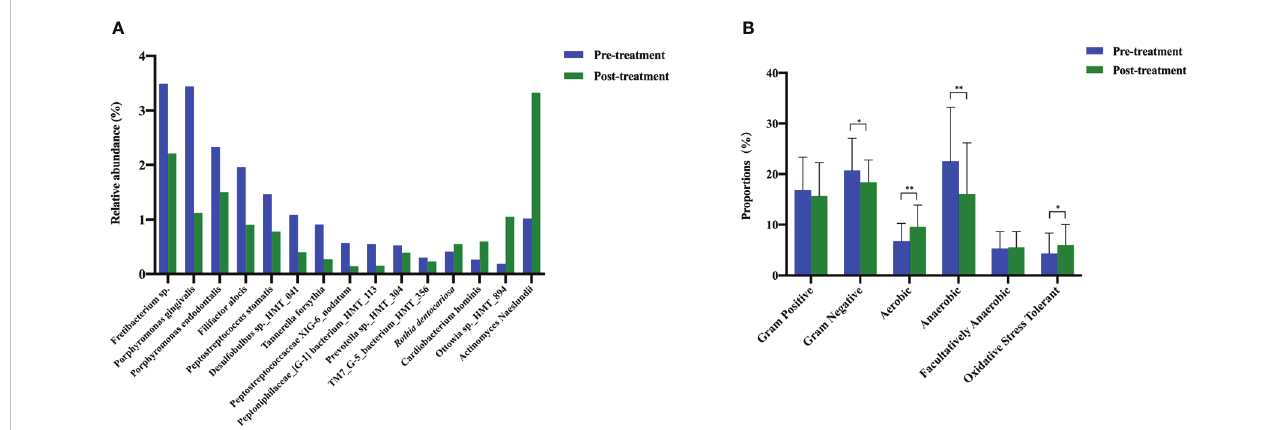
FIGURE 5 The changes in the bacterial types and microbiome phenotypes after mechanical non-surgical treatment. (A) Microbes with signi fi cant shifts after mechanical non-surgical treatment. (B) Microbiome phenotype prediction by Bugbase. ** p < 0.01, * p < 0.05 by Wilcoxon rank-sum